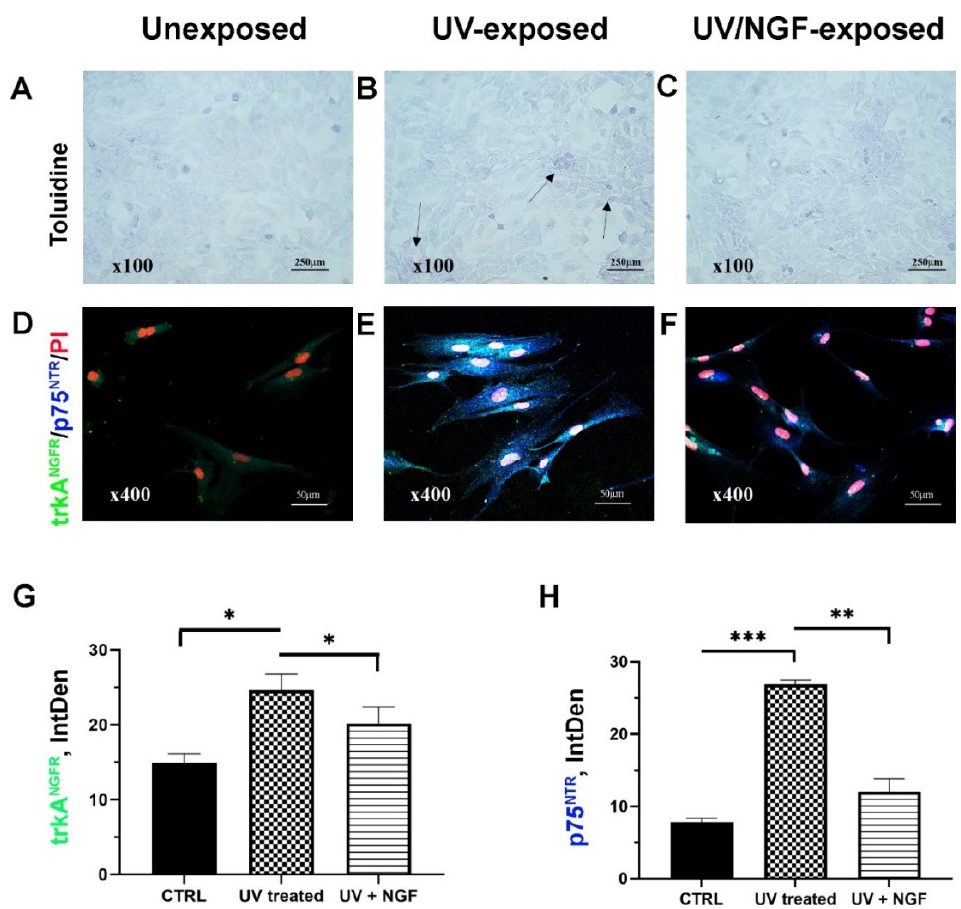
Figure 1. Cell morphology and NGF receptors. Light (toluidine) and confocal (immunofluorescence) images of conjunctival monolayers after 24 h of culturing as: unexposed ( A , D ); UV-exposed ( B , E ), and UV/NGF-exposed (( C , F ); 10 ng/mL NGF). Detached cells were less than 10% in UV-exposed monolayers (see arrows, ( B ) vs. ( A )), and no difference in monolayer appearance was observed in UV/NGF-exposed in comparison to unexposed ones (( C ) vs. ( A )). Representative confocal images display a strong trkA NGFR (green) and rather absent p75 NTR (blue) immunoreactivity in unexposed conjunctival fibroblasts ( D ). Both trkA NGFR and, particularly, p75 NTR immunostainings were increased in UV-exposed cells as compared to untreated ones (( E ) vs. ( D )). Low trkA NGFR immunoreactivity was observed in UV/NGF-exposed cells with respect to untreated ones, in com- parison to p75 NTR immunoreactivity (( F ) vs. ( D )). Nuclear staining: propidium iodide (PI/red). Magnifications: × 100 ( A – C ), × 400 ( D – F ). Integrated densitometric analysis (Image J) was carried out on single channel trkA NGFR ( G ) and p75 NTR ( H ) immunostainings. CTRL, unexposed monolayers. ANOVA followed by Tukey–Kramer post hoc analysis highlighted the significant effects indicated in the graphics (* p < 0.05, ** p < 0.01 and *** p < 0.001) with respect to